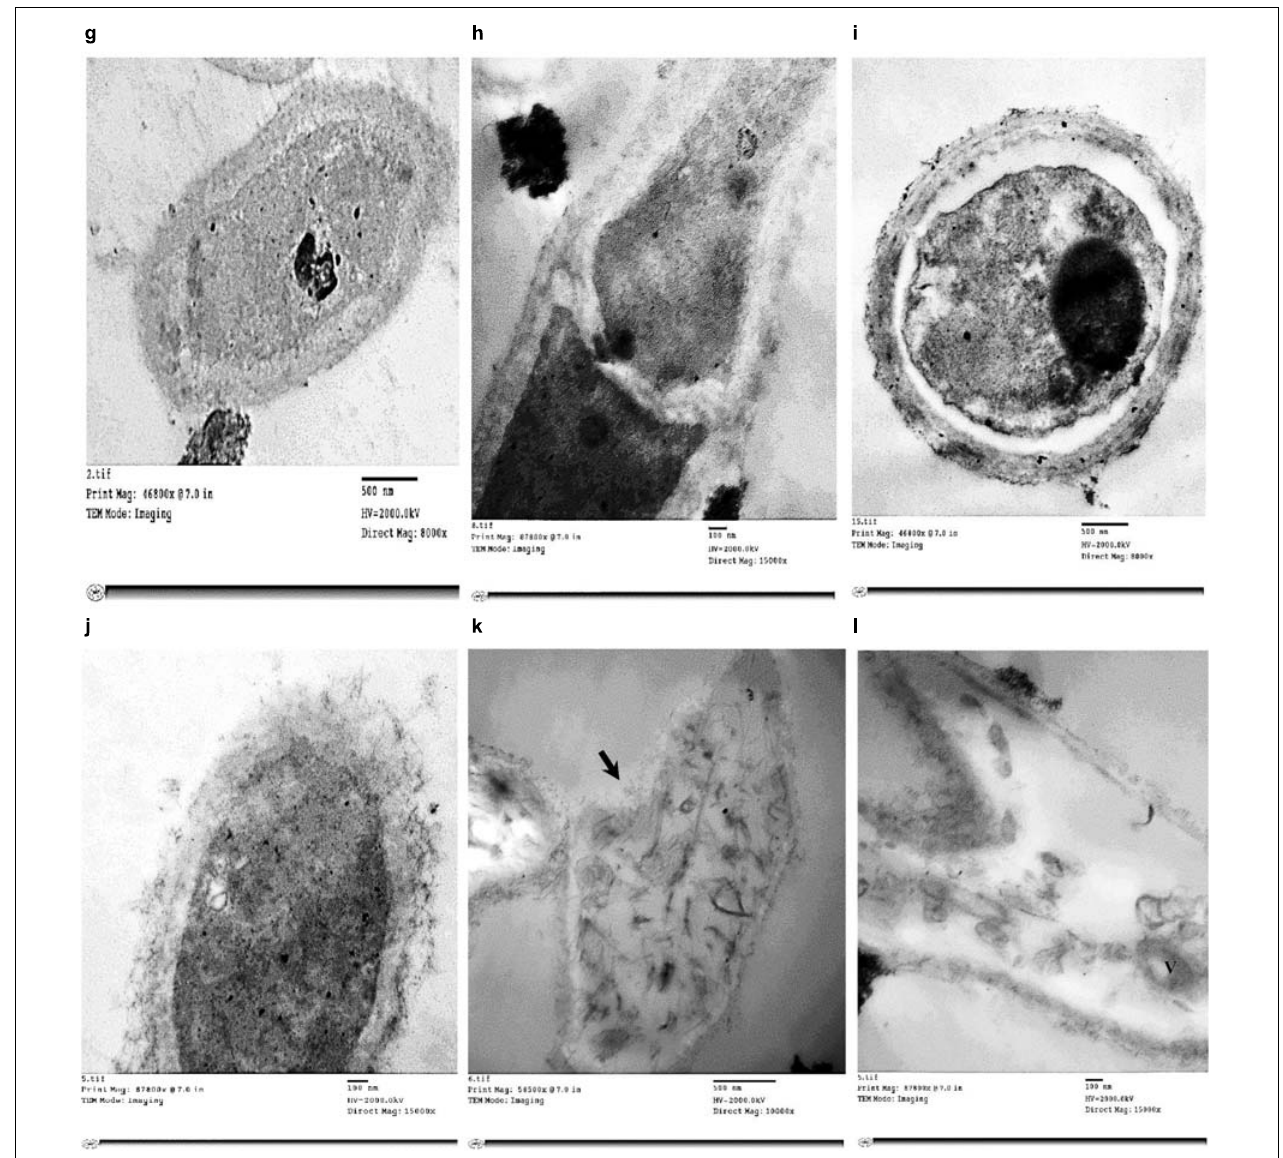
FIGURE 3 | Electromicrographs of T. rubrum cells examined by TEM showing untreated cells with normal cell wall, membranes and cytoplasm (a) , some fatty droplets (F) appear as deep dark rounded spots (b) , normal septal walls (SW) of hyphae displaying lipid extruded via hyphal pore & nucleus (N) clearly distinguished (c) , some irregularities in urea -treated cells (d) , damage in the cell wall (e) , separated cell wall in urea-treated cells as pointed by the arrow (f) , less dense cytoplasm, thickened cell wall & normal hyphal septa in cells treated with 0.25 mg/L of miconazole (g,h) , plasmolysis & shrink cytoplasm with indented membrane in cells treated with 20% urea and 0.001 mg/L miconazole (i) , more thickened cell wall with severe damage as debris & disintegrated organelles in cells treated with 20% urea/0.002 mg/L miconazole (j) , necrotic cells with punctured wall (arrow, k) , collapsed cells with degraded cytoplasmic content & remnants of the membrane in the form of vesicles (V) within the cytoplasm in cells treated with 0.003 mg/L of miconazole combined with 20% urea (l)